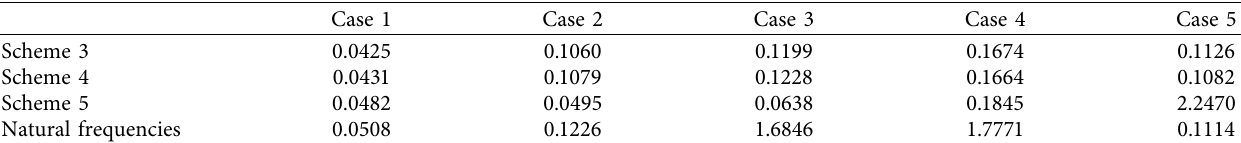
Table 5: RMSE (%) of the 5 cases.